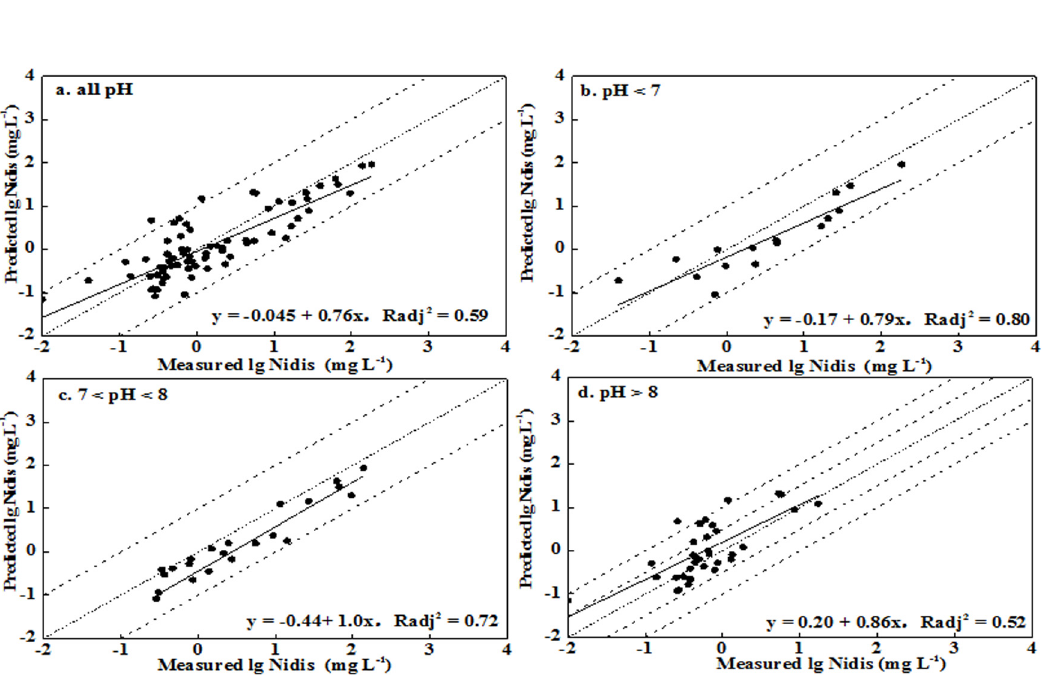
Fig 4. Measured soluble Ni concentration versus predicted Ni concentration using Visual MINTEQ for leached soils (Ni dis represented the soluble Ni concentration in soil pore water).